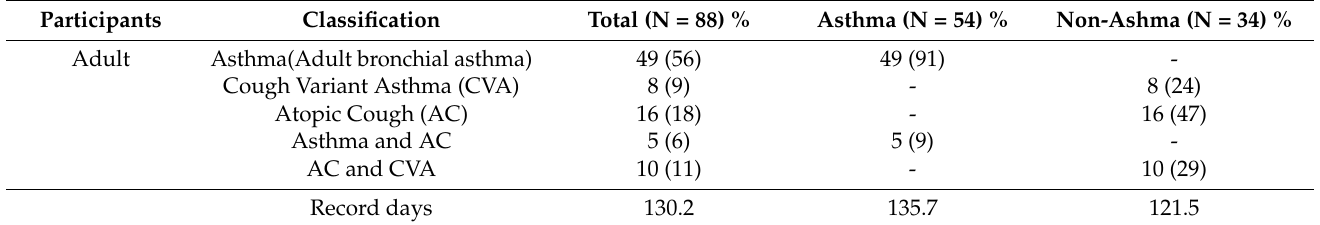
Table 2. Information of the statistical analysis for the longitudinal